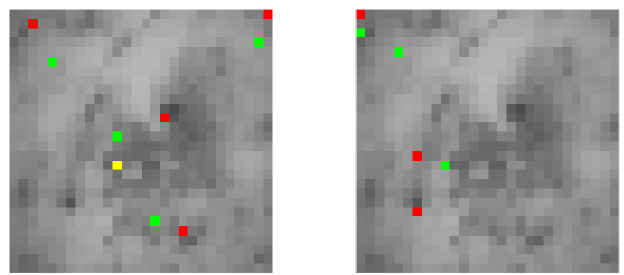
Figure 22. A case classified as “benign” by both C4.5 (left) and a CNN (right). Colored dots represent the rule antecedents.